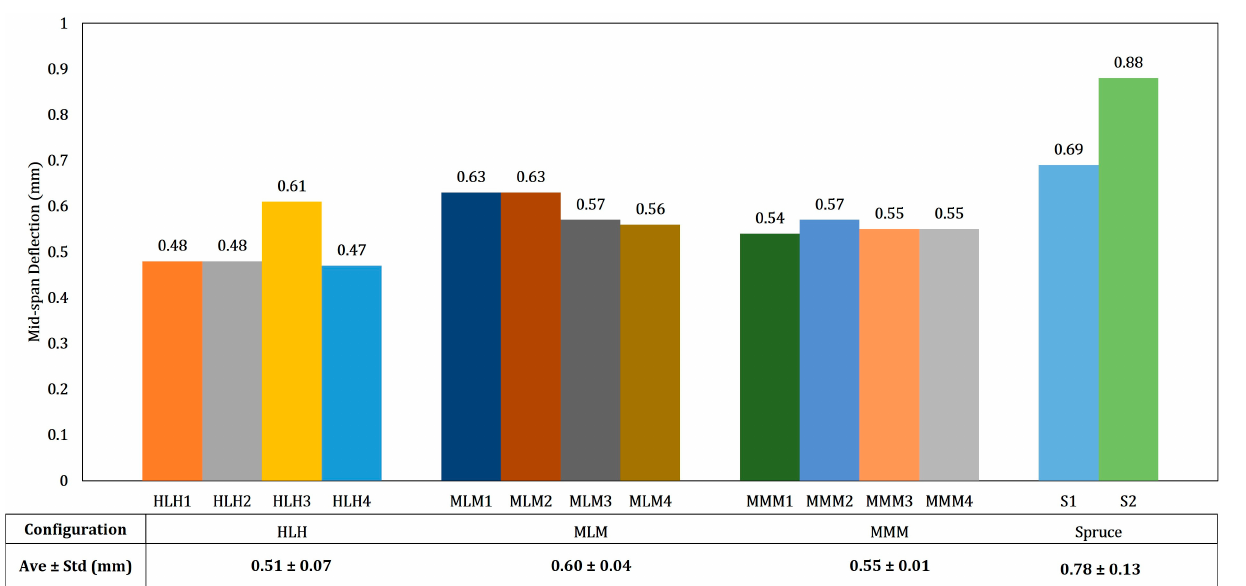
Figure 4. Test results of the mid-span deflection under 1.25 kN of serviceability load.